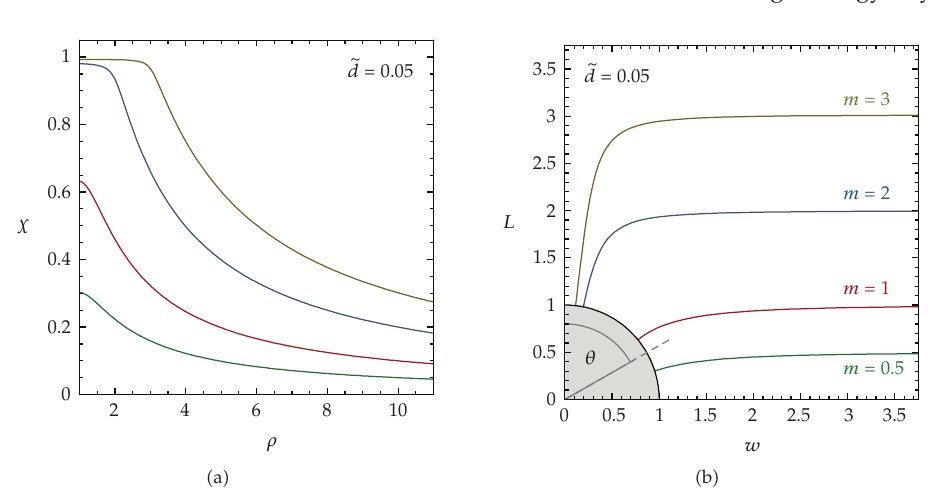
Figure 6: Examples for the embedding function χ (cid:2) ρ (cid:3) with χ (cid:5) cos θ and the according profile L (cid:2) w (cid:3) . Matching colors indicate corresponding curves.